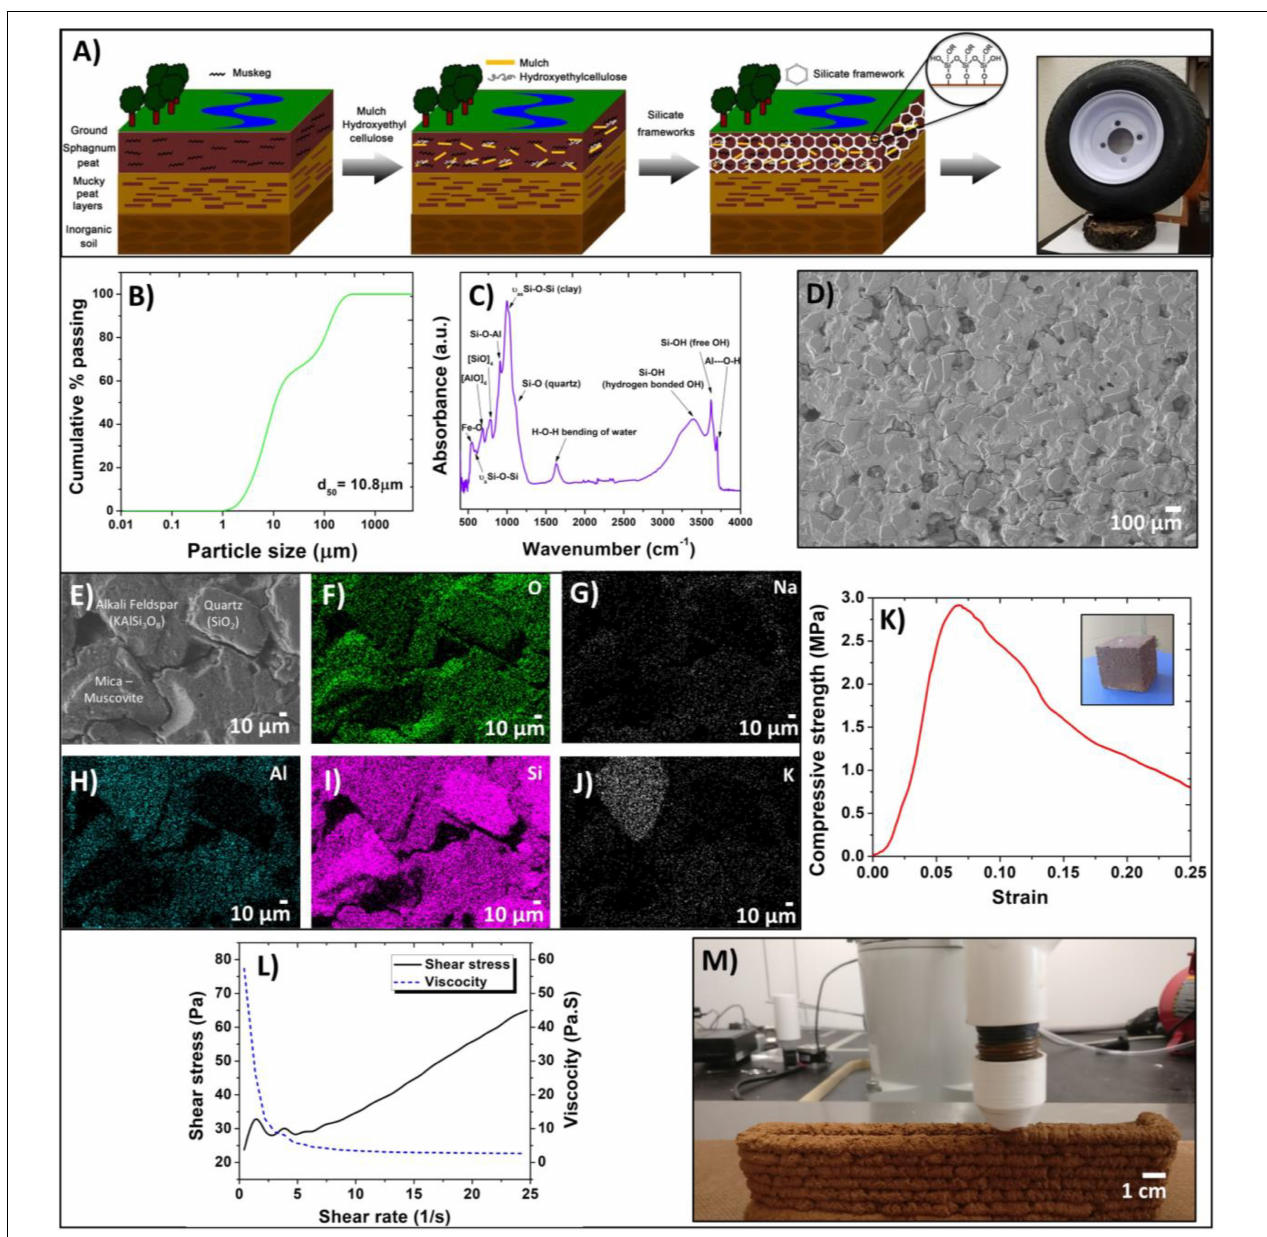
FIGURE 2 | (A) Illustration of geopolymerization approach developed to solidify muskeg to a load-bearing silicate composite, as represented by the force of an automobile tire on road reinforced by the composite, reprinted with permission from Waetzig et al. (2017) Copyright 2017 Springer Nature. (B) Particle size analysis of locally sourced Burlewash clay. (C) Attenuated total reflectance – Fourier transform infrared spectrum (ATR-FTIR) measured for Burlewash clay. (D,E) Scanning electron micrograph of the Burlewash clay composite. Spatially resolved elemental mapping using energy dispersive X-ray analysis at (F) oxygen; (G) sodium; (H) aluminum; (I) silicon; and (J) potassium edges. (K) Compressive strength testing of the burlewash clay composite; a digital photograph of the cube used for testing is shown in the inset. (L) Rheological curves measured for the printable burlewash clay formulation. (M) Digital photograph depicting the extrusion step of the 3D-printing process for burlewash series clay composite